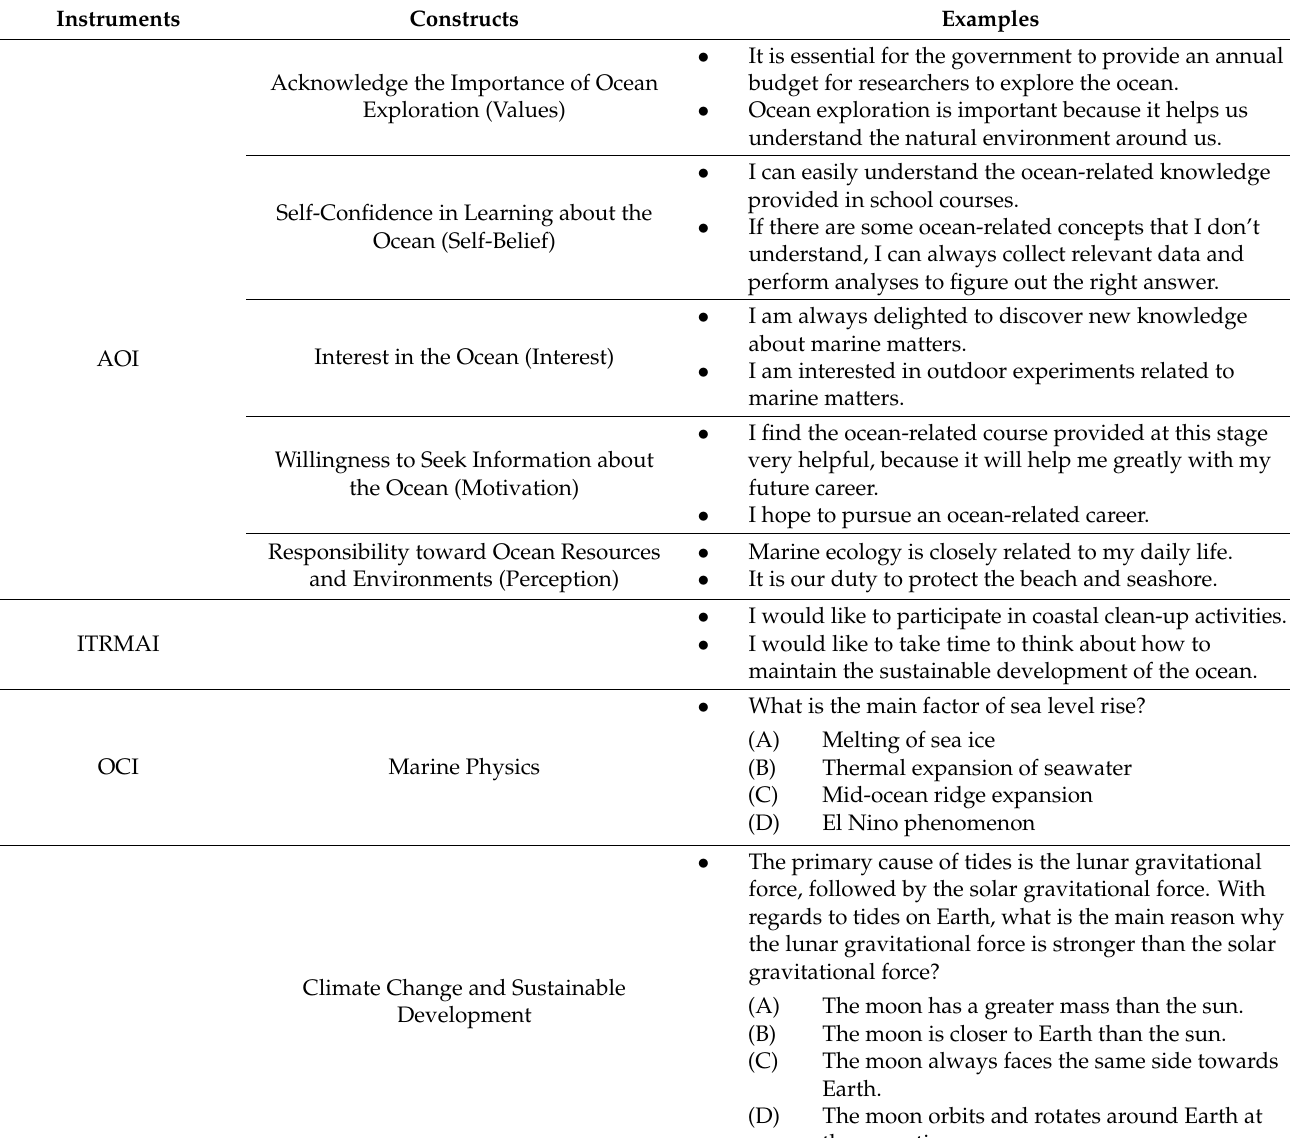
Table 1. AOI, ITRMAI, and OCI